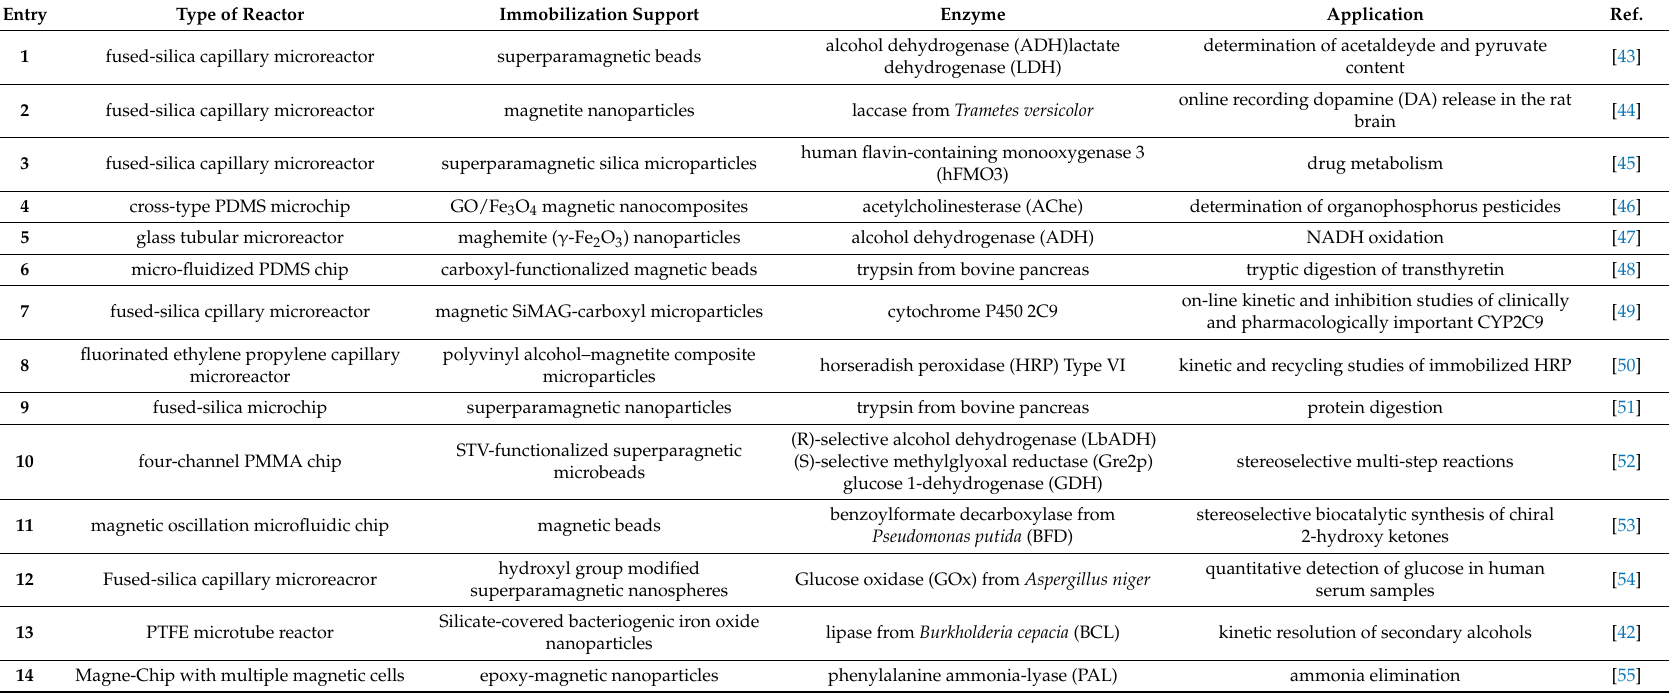
Table 1. Summary of studies utilizing magnetic enzyme